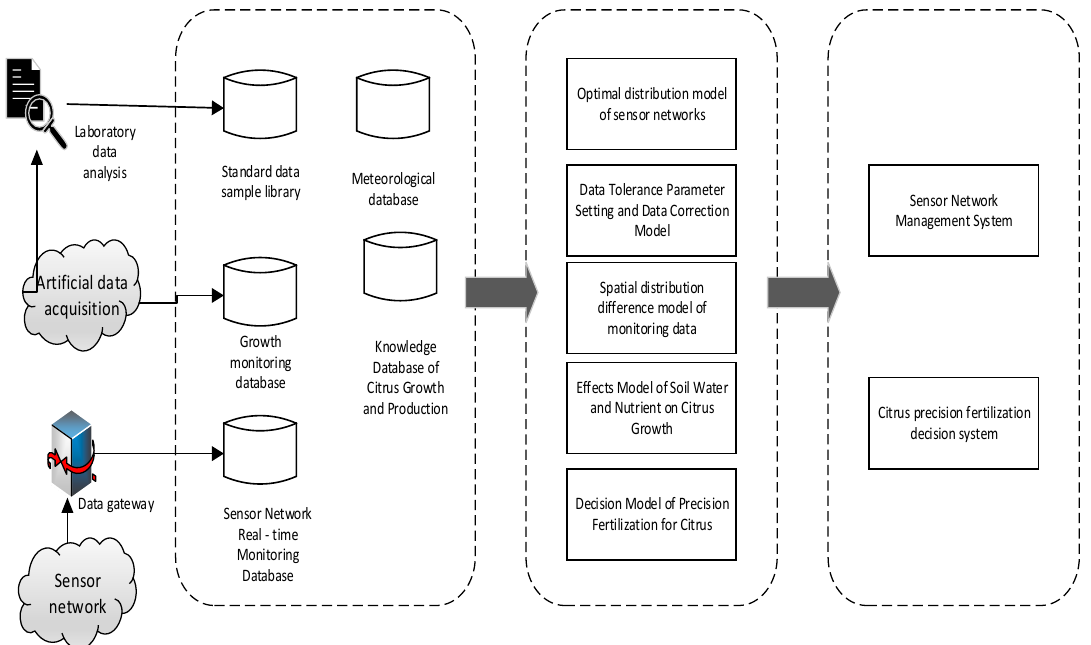
Figure 1. Overall system architecture diagram.